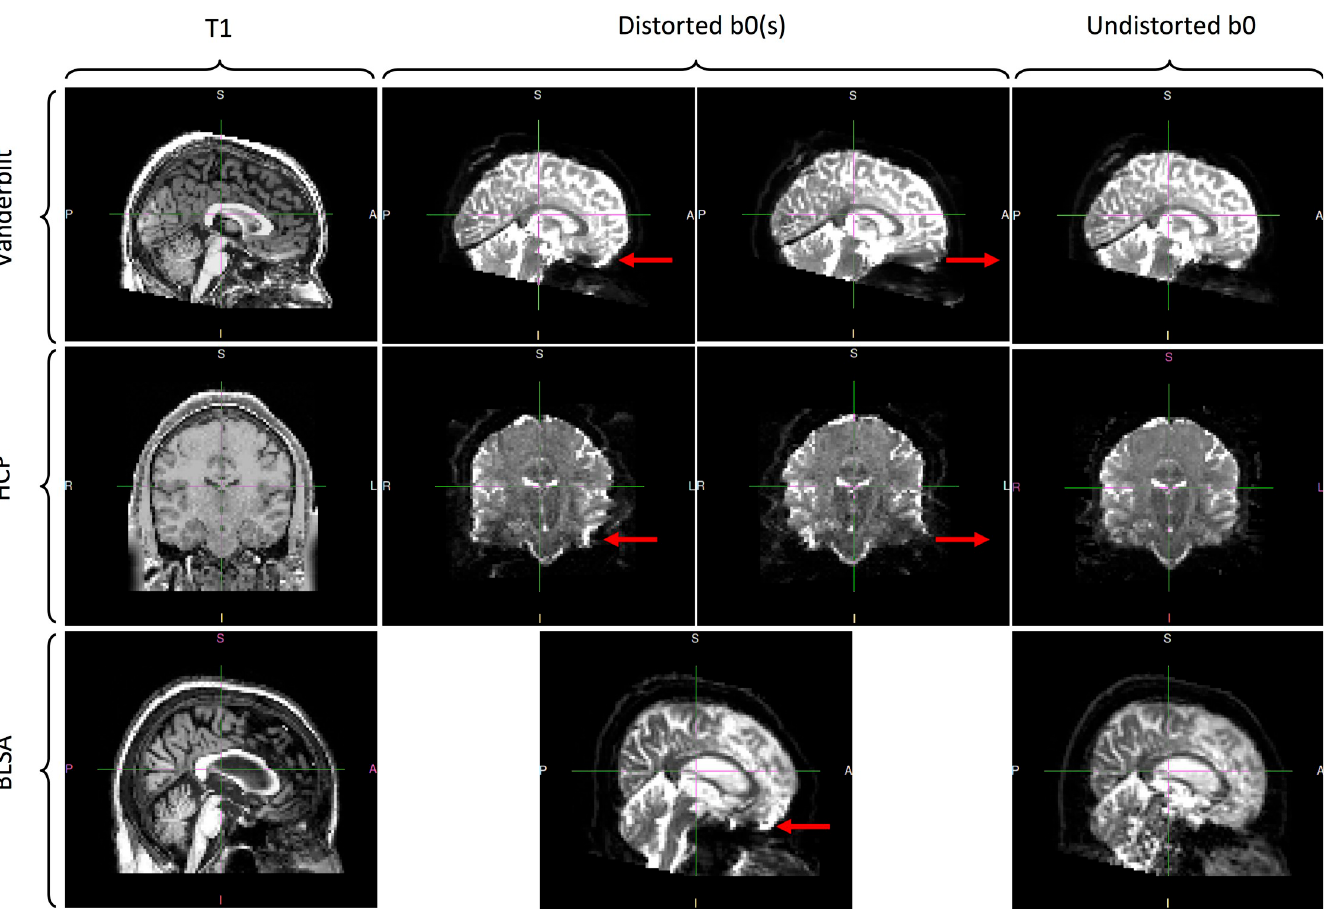
Fig 2. Datasets used in this study. The b0’s from Vanderbilt were acquired with opposite phase encodings along the A-P direction and corrected with topup. The b0s from HCP were acquired with opposite phase encodings along the L-R direction and corrected with topup. Lastly, b0s from BLSA were acquired with a single phase encoding along the A-P direction and corrected via a multi-shot EPI acquisition. The arrows in the distorted b0 columns highlight areas of visible susceptibility distortion.